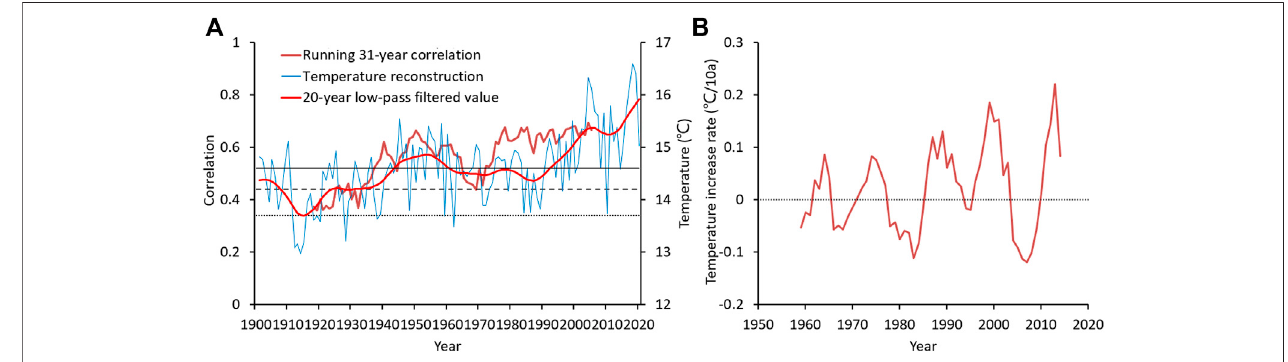
FIGURE9|(A) Comparisonoftemperaturereconstructionwithrunning31-yearcorrelationbetweenthecompositechronologyandCRUJune – Julytemperatures. The dash and dotted lines indicate the 95 and 99% signi fi cance level, respectively. (B) The moving ten-years increase rate of temperature